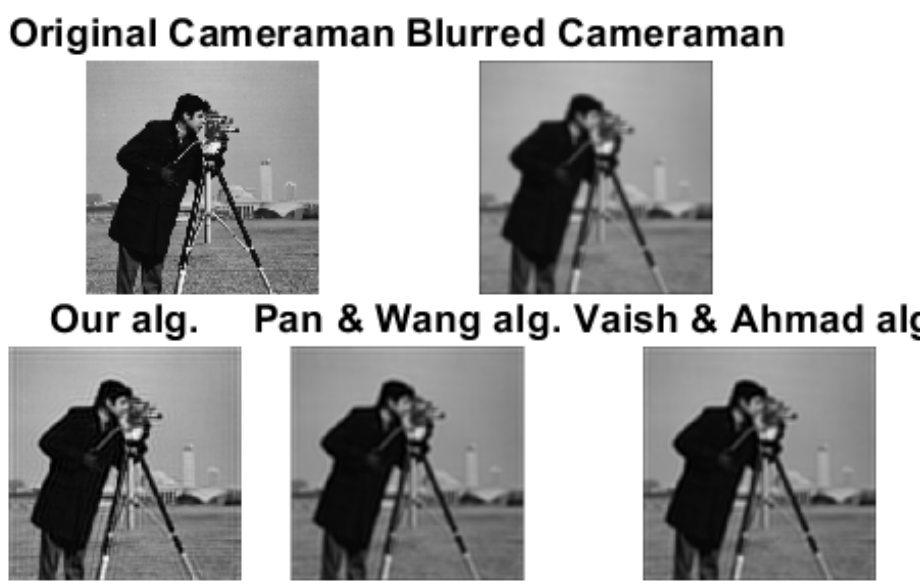
Figure 3. Example 2. The top row shows the original Cameraman image ( left ) and the degraded Cameraman image ( right ). The bottom row shows the images recovered by our algorithm, by the algorithm of Pan and Wang, and by that of Vaish and